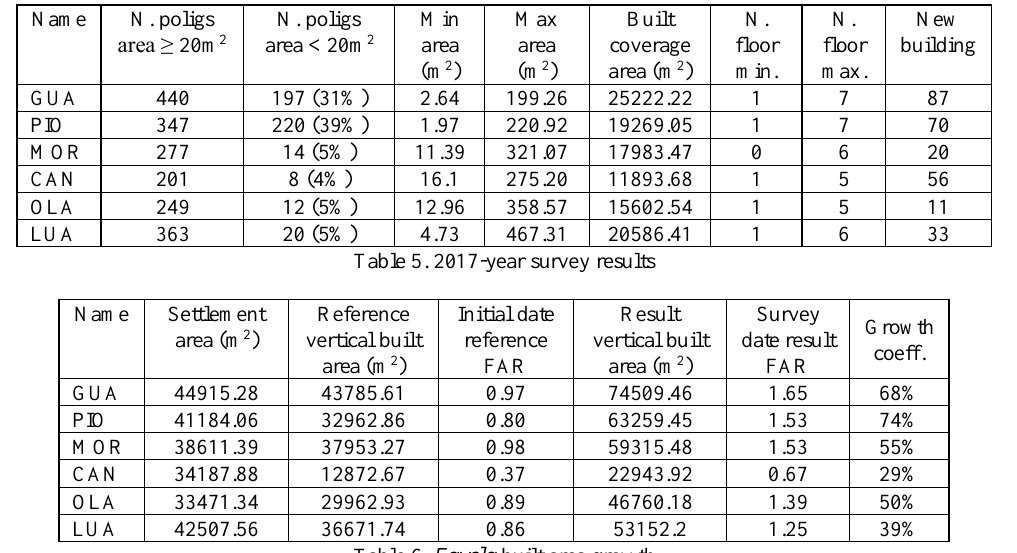
Table 6. Favela built area